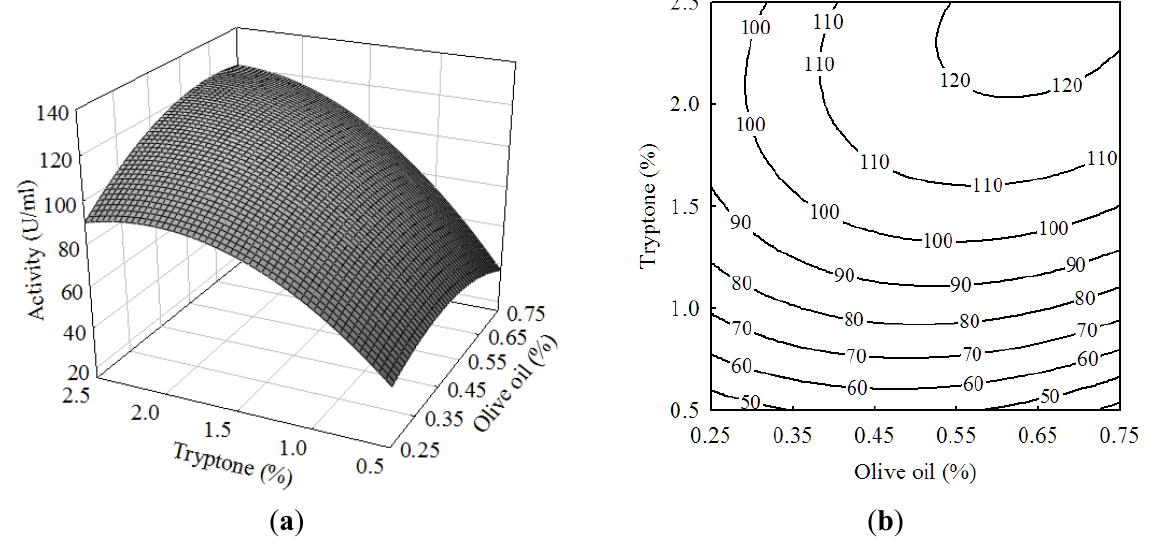
Figure 2. ( a ) Response surface curve and ( b ) contour plot showing the effects of olive oil and Tween-80 on the lipase activity of Burkholderia sp.